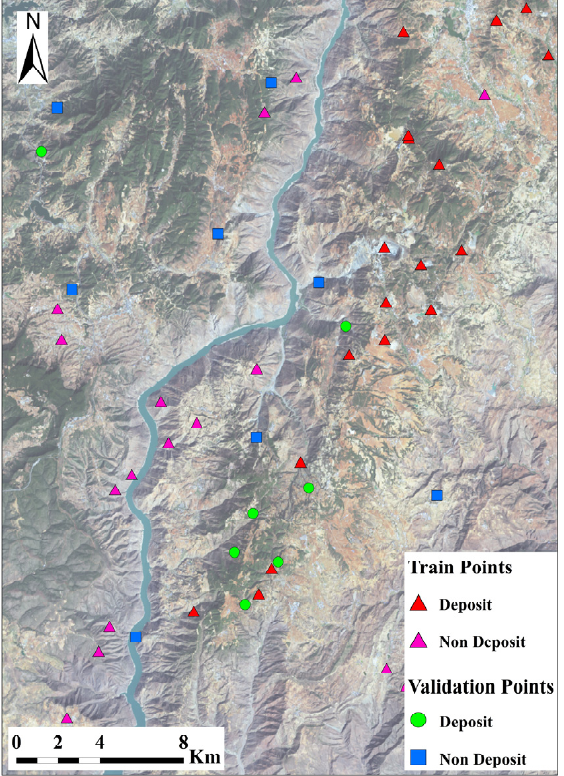
Figure 9. Location map of deposits and non-deposit training and validation sites used for training the neural networks.